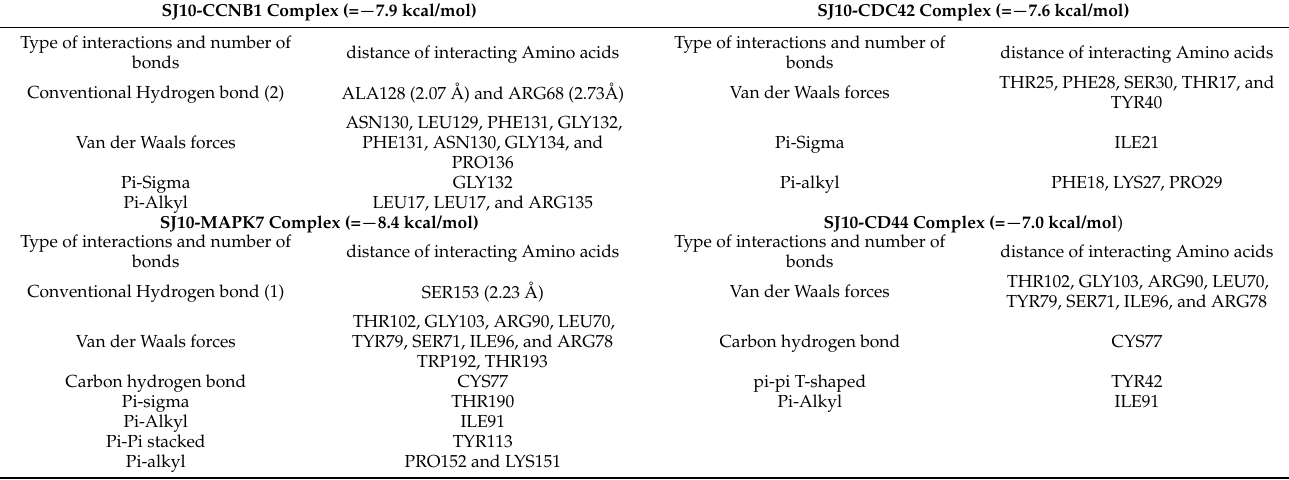
Table 2. Analytical summary table showing interactions of SJ10 with CCNB1/CDC42/MAPK7/ CD44